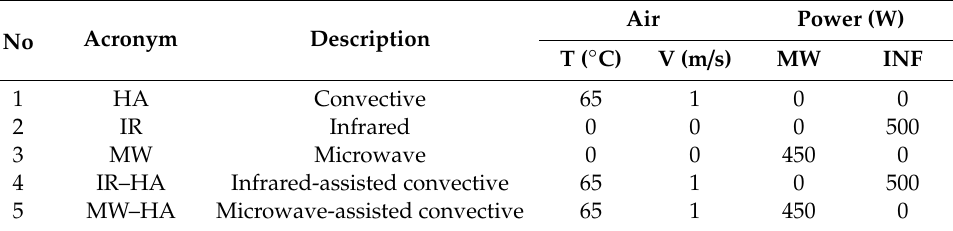
Table 1. Description of the drying programs.